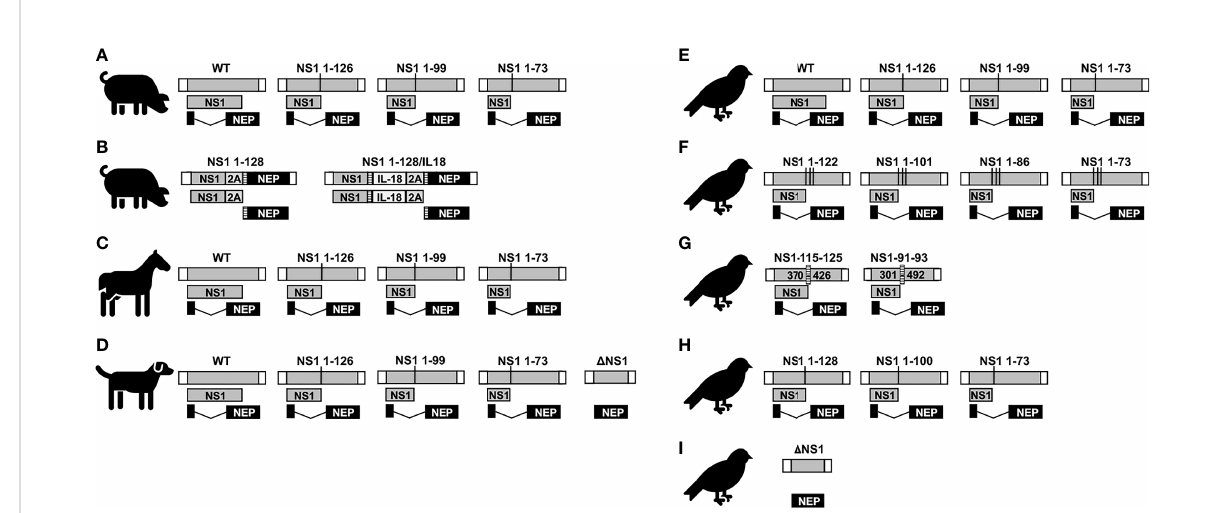
FIGURE 6 NS1 truncated or de fi cient IAV as LAIV for SIV (A and B), EIV (C), CIV (D), and AIV (E – I). Schematic representation of the WT and modi fi ed NS segments for SIV (A, B) , EIV (C) , CIV (D) , and AIV (E – I) . NS vRNA is represented in gray boxes and the NCR located at the 3´and 5´ ends of the NS vRNA are indicated with white boxes. NS1 and NEP ORFs are represented as gray and black boxes, respectively. Black lines represent stop codons. In (B) , truncated NS1 protein is expressed as a single polyprotein together with 2A autoproteolytic cleavage site and NEP. NEP protein is released from NS1 protein during translation. IL-18 was incorporated between NS1 and NEP proteins via GSGG and GSG linkers (striped rectangles), and the 2A autoproteolytic cleavage site. Splice acceptor site was mutated to inhibit splicing. In (F) , the NS segments encoded unmodi fi ed NEP and truncated NS1 protein products created by adding three serial stop codons comprising amino acids 1-73, 1-86, 1-101, and 1-122 without any nucleotide deletions. In (G) , the internal deletion comprising nucleotides 370-426 (NS1-115-125) or 301-492 (NS1-91-93) in NS1 are indicated. The CCT of these NS1 proteins contains the same 115 and 91, respectively, amino acid residues than the WT NS1 but additional different residues (116 to 125 for NS1-115-125; and 92 to 93 in NS1-91/93, respectively) due to a frame shift in the